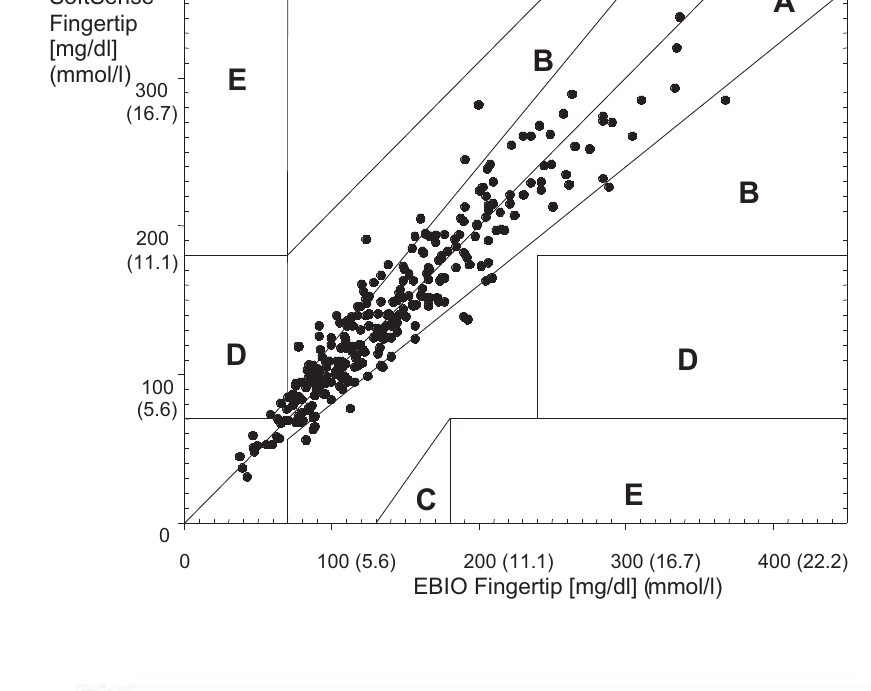
Bland-Altman-analy- sis of the Soft-Sense measurements at the fingertip compared with the reference method. The black lines frame the area of acceptance as given by the new ISO/DIS 15197 guide- lines.